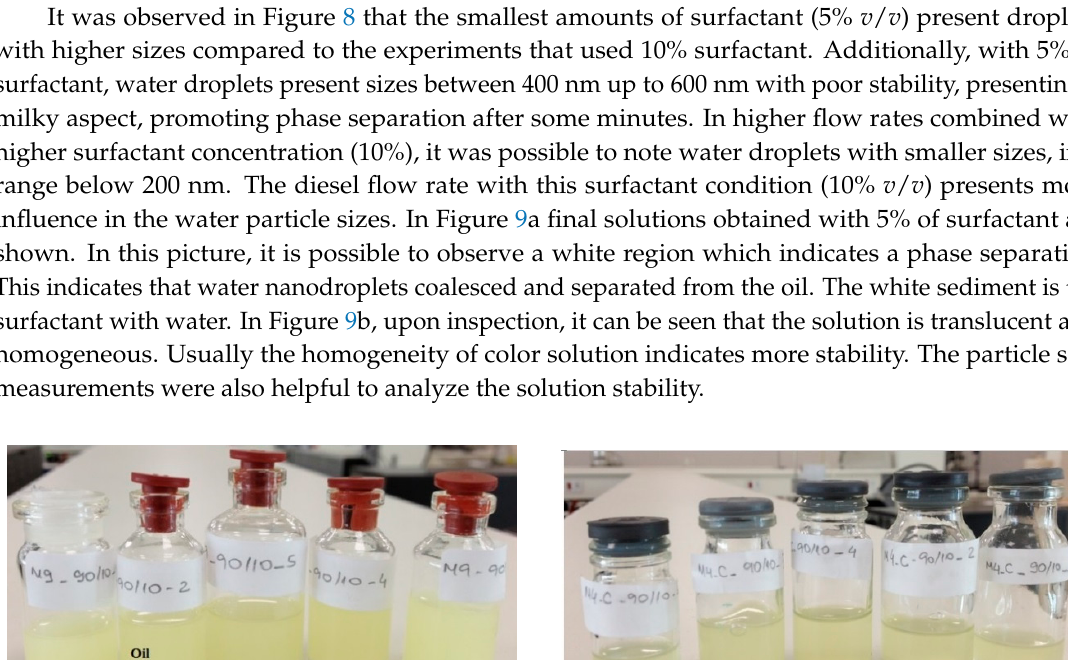
Figure 8. Water-in-diesel emulsion: water droplets size in function of diesel flow rate for two surfactant concentration (5% and 10% v / v ).